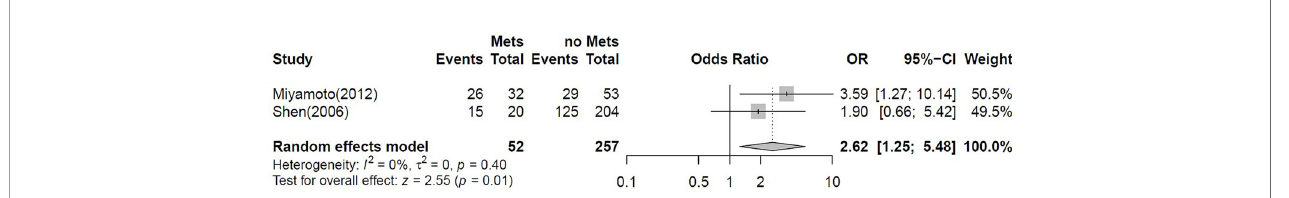
FIGURE 4 | Forest plot for the binary meta-analysis stablishing the association between ER b positivity and lymph node metastasis. Individual study estimates of crude odds ratios (OR) and 95% con fi dence intervals (CI). The diamond at the bottom of the plot denotes the random effects estimate. Error bars indicate con fi dence intervals. Heterogeneity